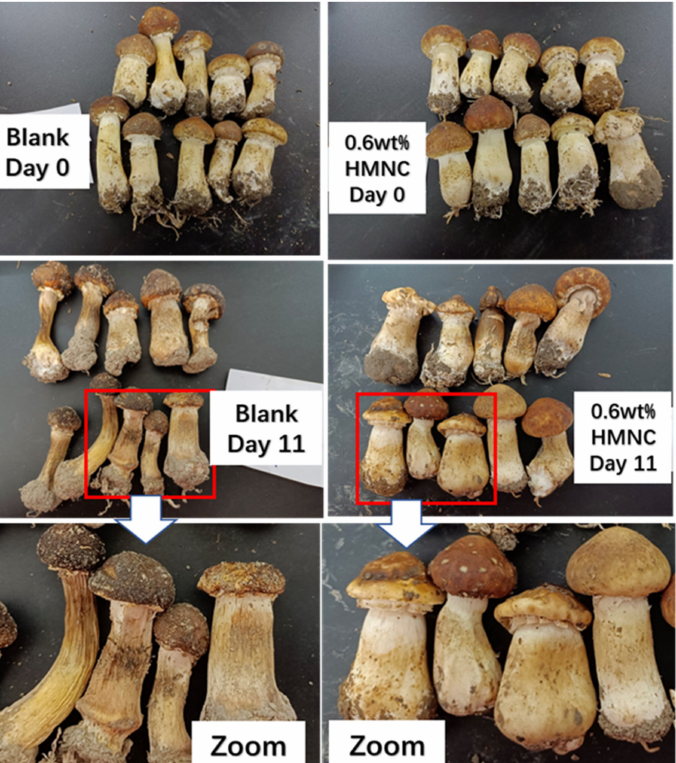
Figure 6. The freshness preservation evaluation of Agaricus mushrooms using commercial PE film and PBAT-HMNC